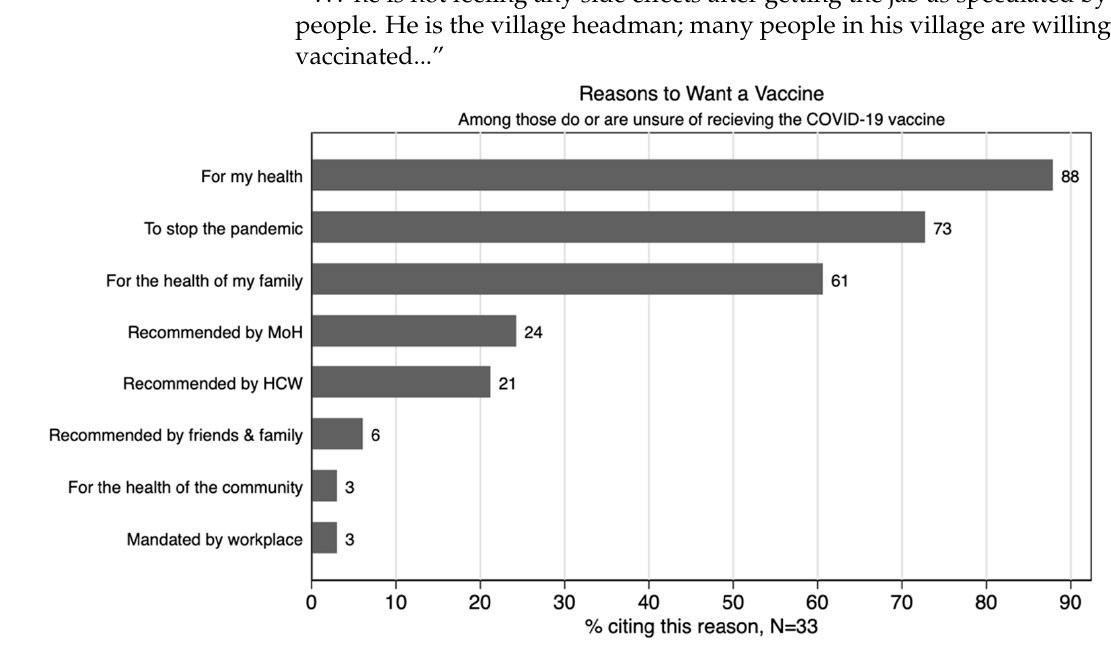
Figure 2. Reason to be vaccinated.